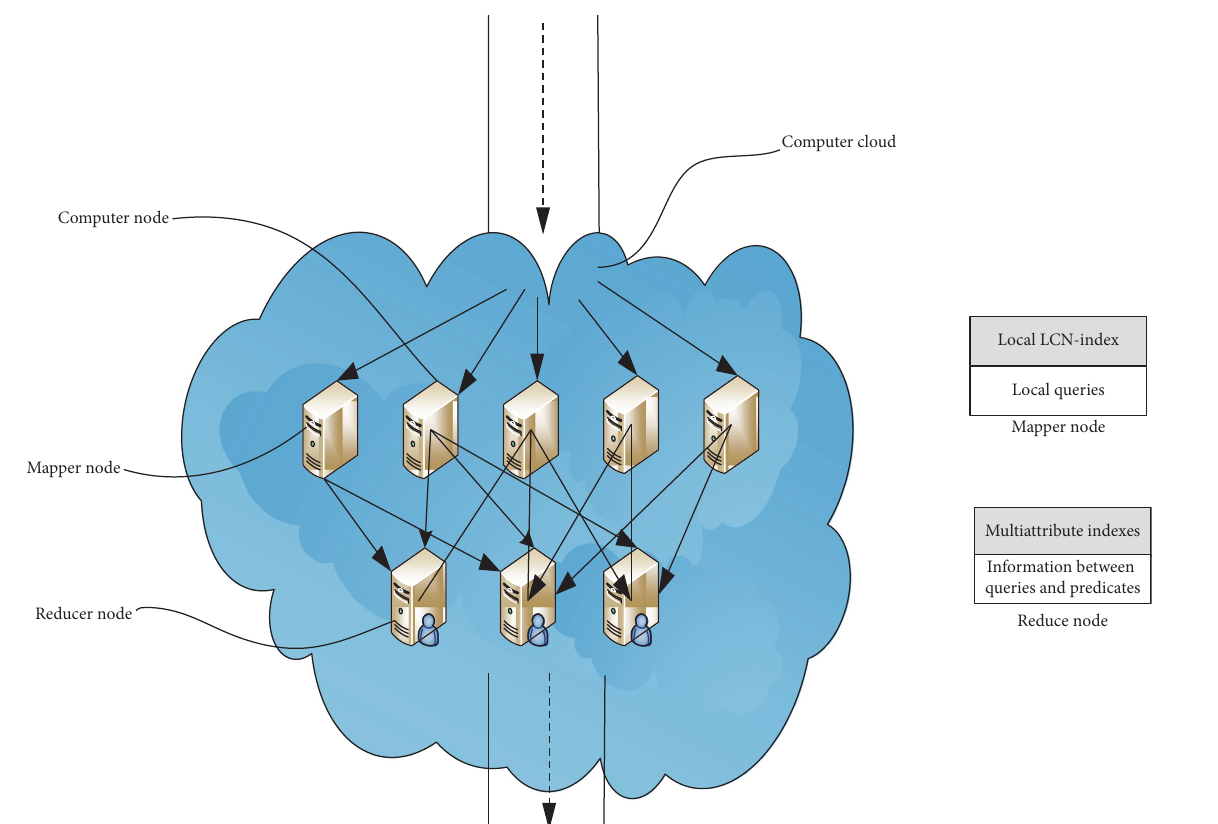
Figure 3: Online data analysis framework: We integrate MapReduce model with query indexes strategy to efficiently support cloud data stream querying. In particular, in our index framework, we build LCN-Index on Mapper and build multiattribute indexes on Reducer. We focus on the highlighted components, local LCN-Index in Mapper and multiattribute indexes matching in Reducer. In Section 3, we will introduce LCN-Index schema. In Section 4, we will introduce the multiattribute index